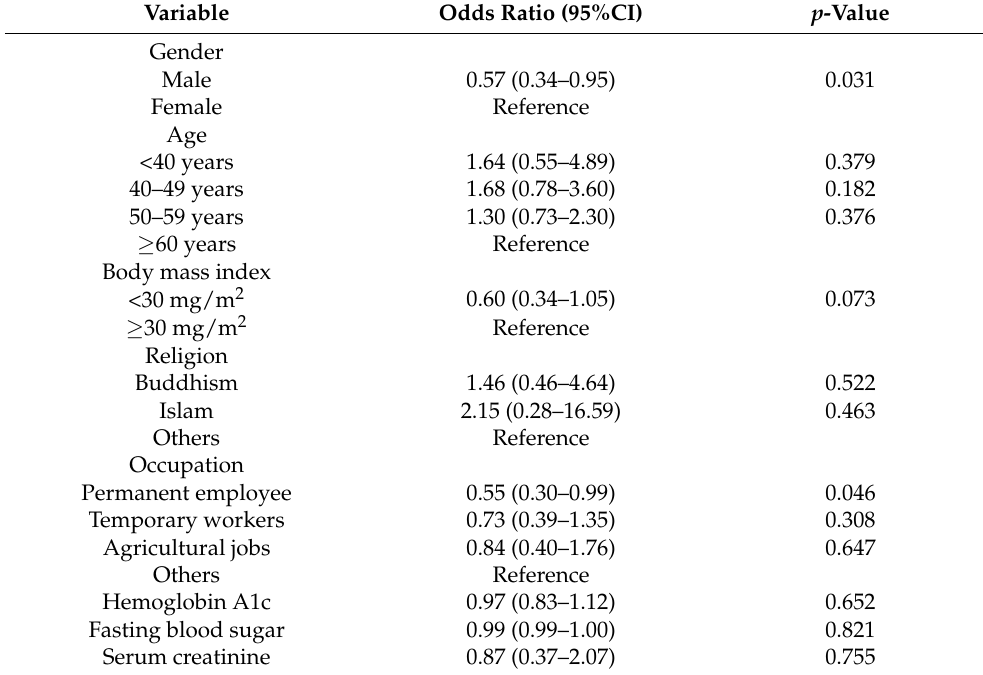
Table 3. The factors associated with UTI events in patients who were treated with SGLT2